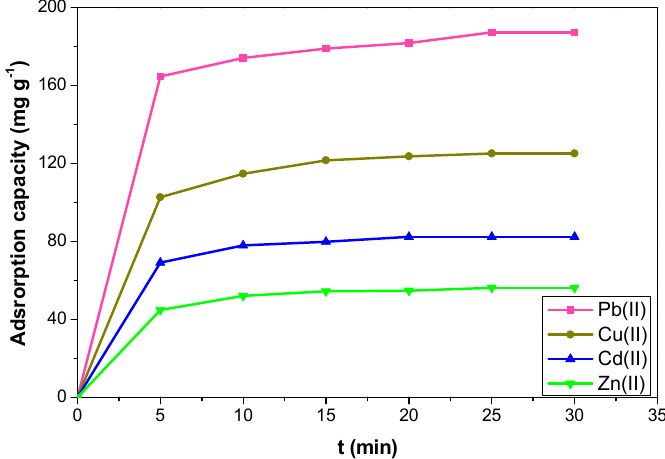
Figure 6. Effect of contact time on SiTF 5 PP adsorption capacity towards Pb(II), Cu(II), Cd(II), and Zn(II). Adsorption dose: V = 10 mL, m = 10 mg of SiTF 5 PP , at optimum pH (pH = 6), 25 ◦ C and optimum concentration (187.36 ppm in each case). Lines just combine the